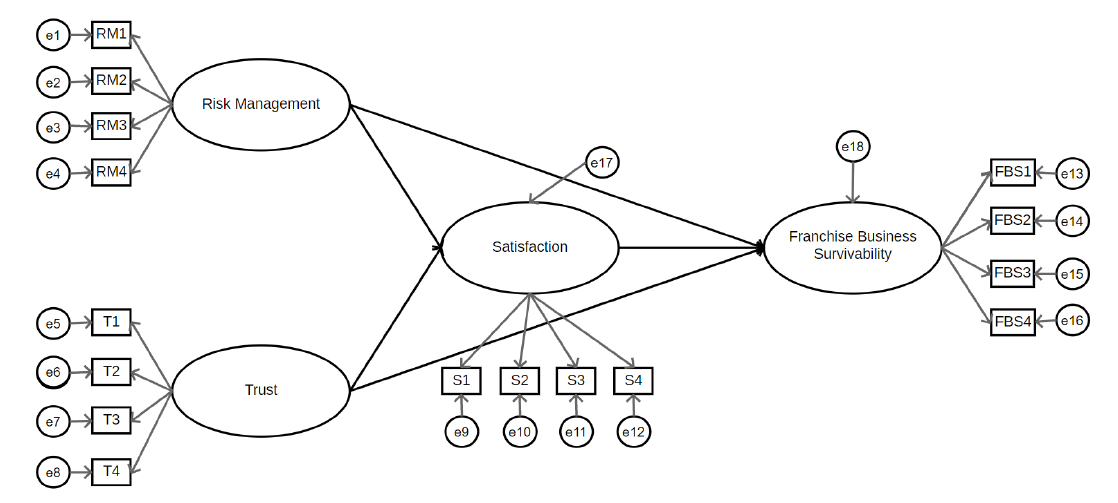
Figure 1. Research